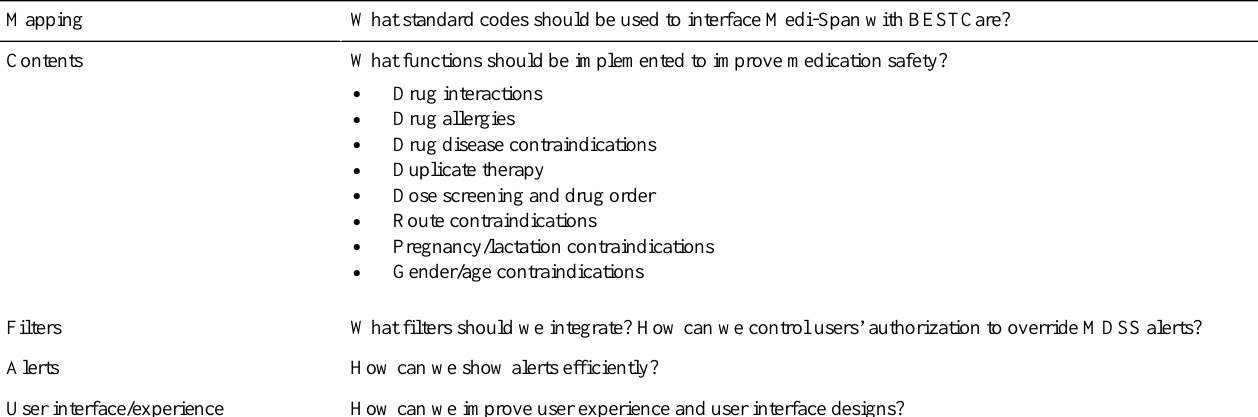
Table 1. Basic considerations for integration of a commercialized MDSS into the EMR system.